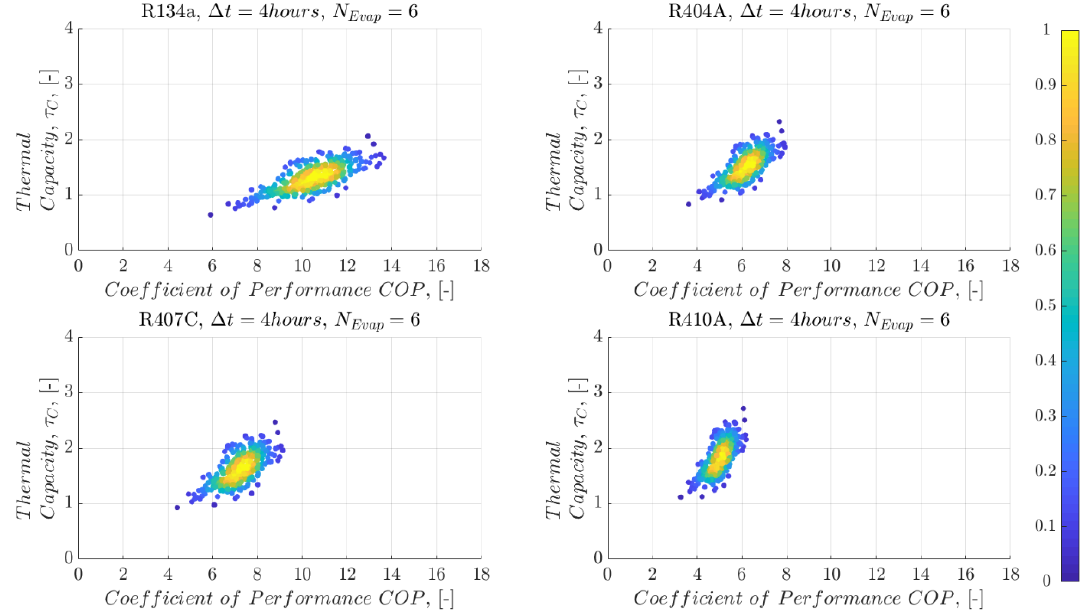
Figure 16. Probability density estimation of the relative efficiencies for all refrigerants and six collectors.